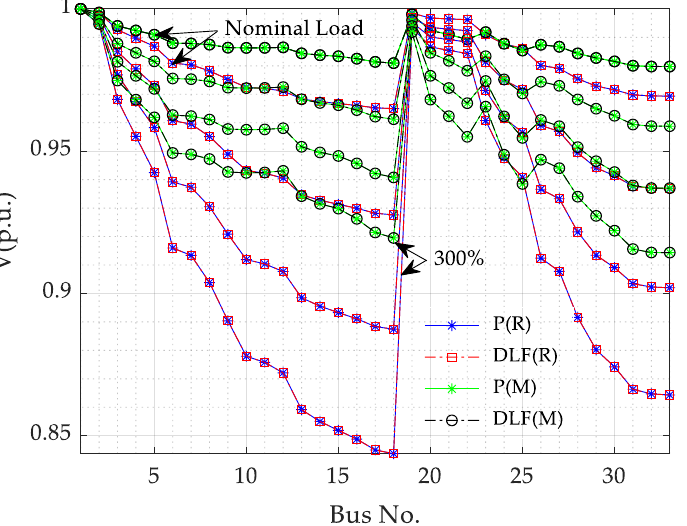
Figure 5. Voltage profile of the 33-node test feeder (P = proposed, R = radial, M = meshed, C1 = Case 1, C2 = Case 2).